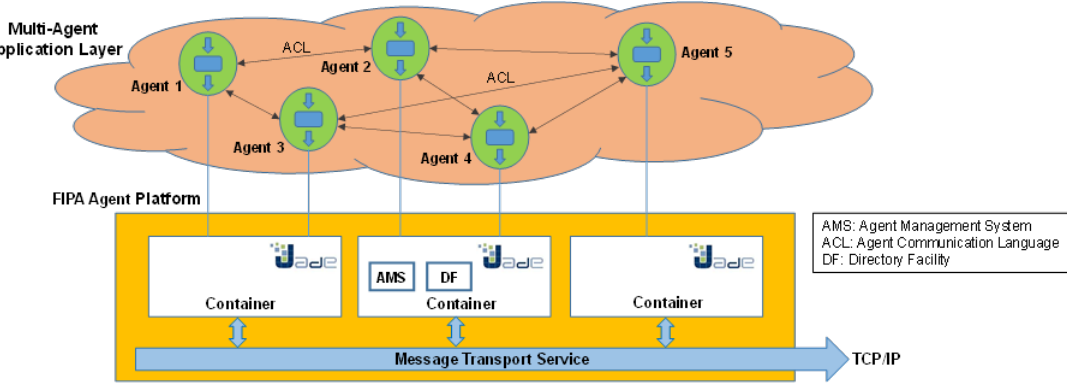
Figure 7. Diagram of the FIPA-compliant MAS platform JADE.